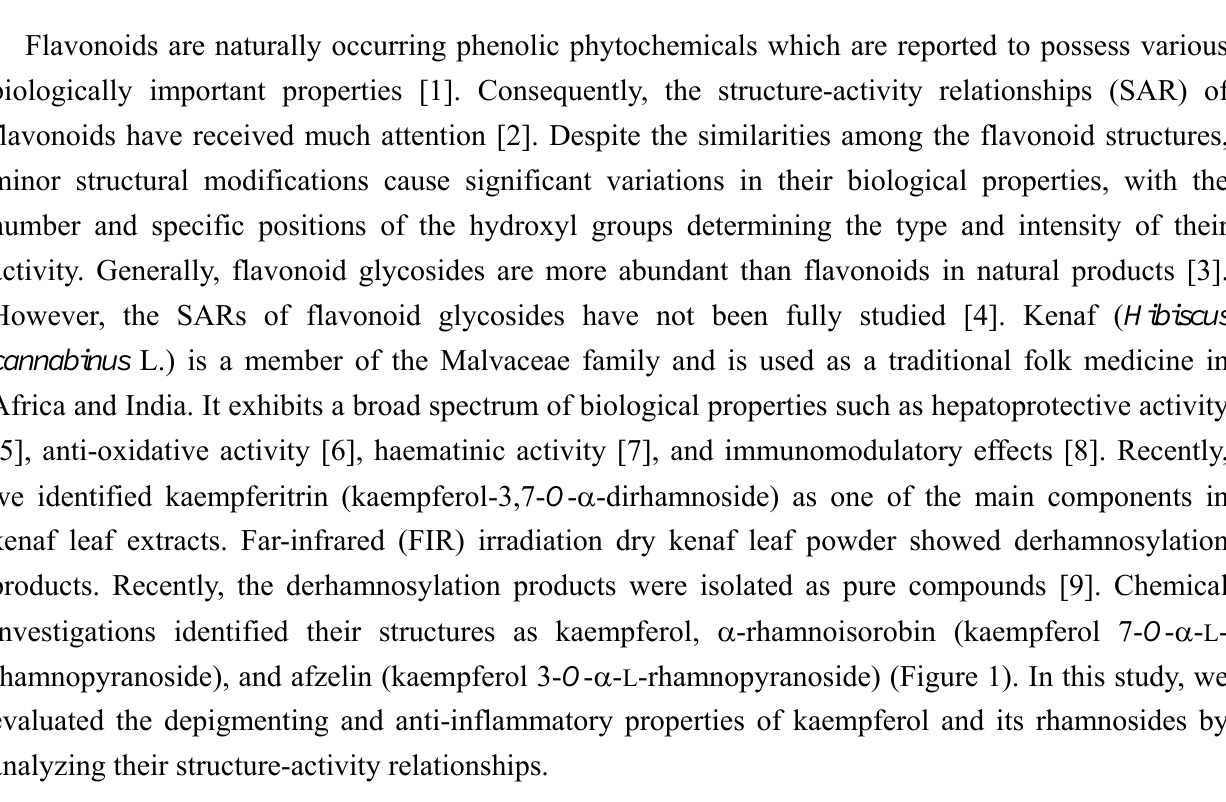
Figure 1. Structure of kaempferol and its